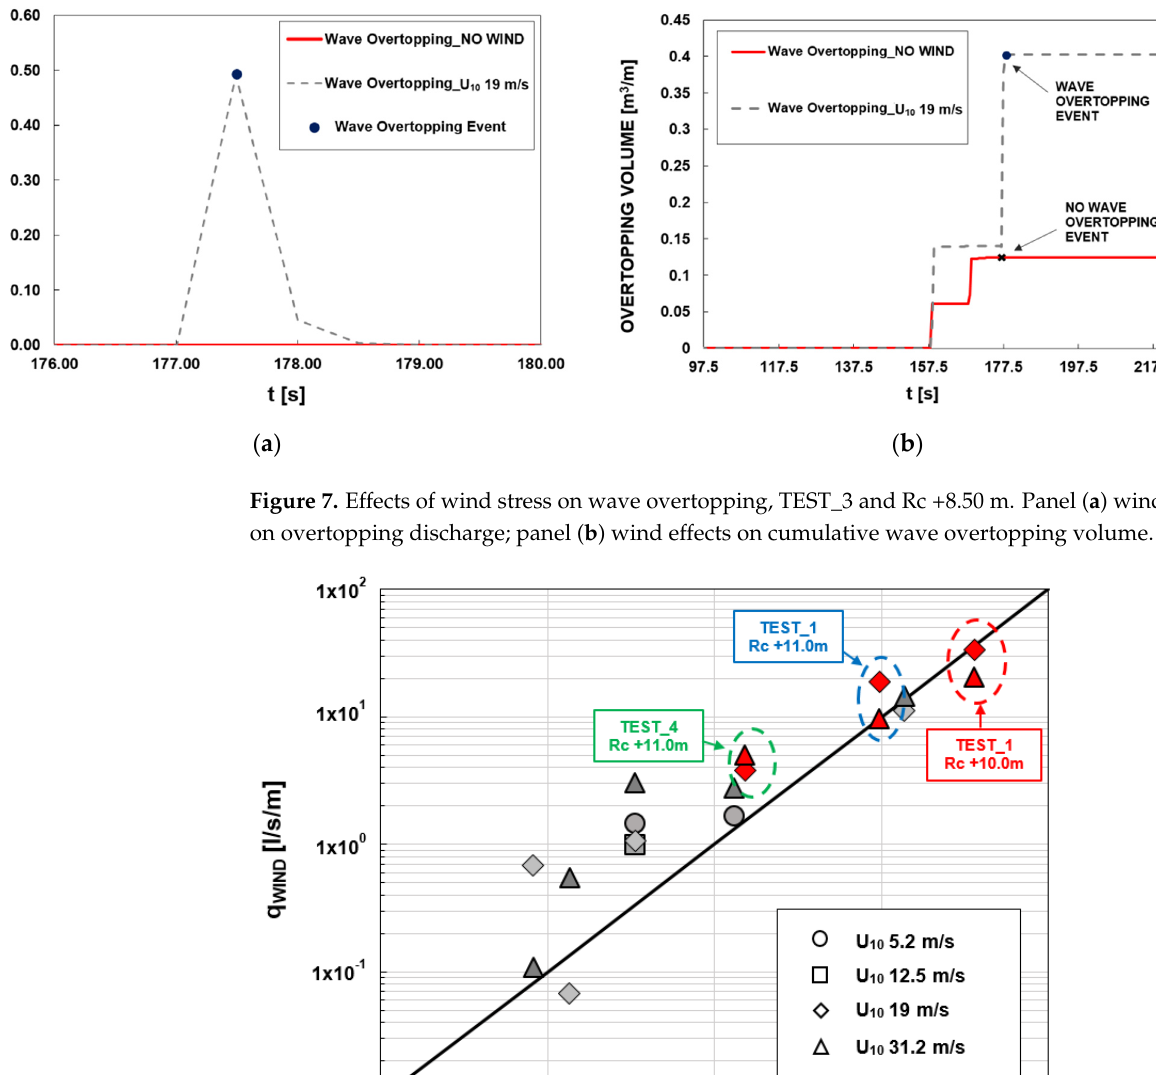
Figure 6. Up-rushing jet on wave overtopping for different simulation at the time 177.5 s, TEST_3 and Rc = +8.50 m. Panel ( a ) no wind; panel ( b ) wind velocity U 10 = 19 m/s.